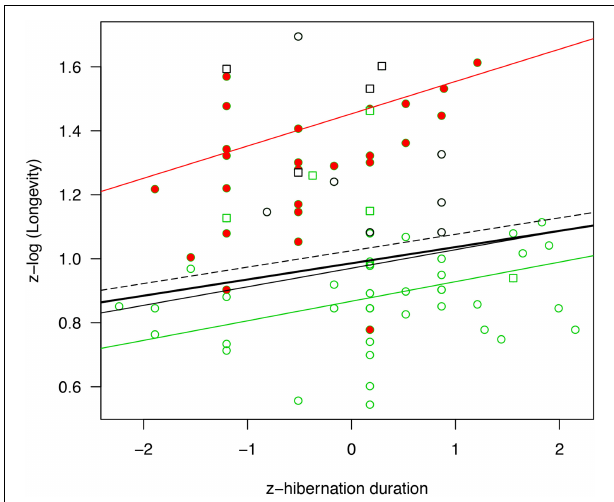
FIGURE 2 | Relationship between hibernation season duration (standardized) and longevity (log-transformed and standardized). The regression lines are presented for PGLS models for all mammals (bold black line, N = 82, p = 0.015), all hibernators without bats (black line, N = 55, p = 0.011), deep hibernators without bats (dashed line, N = 46, p = 0.028) and small hibernators without bats (green line, N = 44, p = 0.005). For comparison, effect sizes from a simple linear model not accounting for phylogeny are presented for bats only (red line, N = 27, p = 0.036). Full red circles highlight bat species, the squares highlight species reducing their energy expenditure during hibernation by less than 90% compared to the euthermic state, green item highlight species below 1.5 kg, and black circle highlight all remaining hibernators above 1.5 kg in the data set. Please note that some dots referring to bat species are superimposed because the corresponding species have the same hibernation season durations and